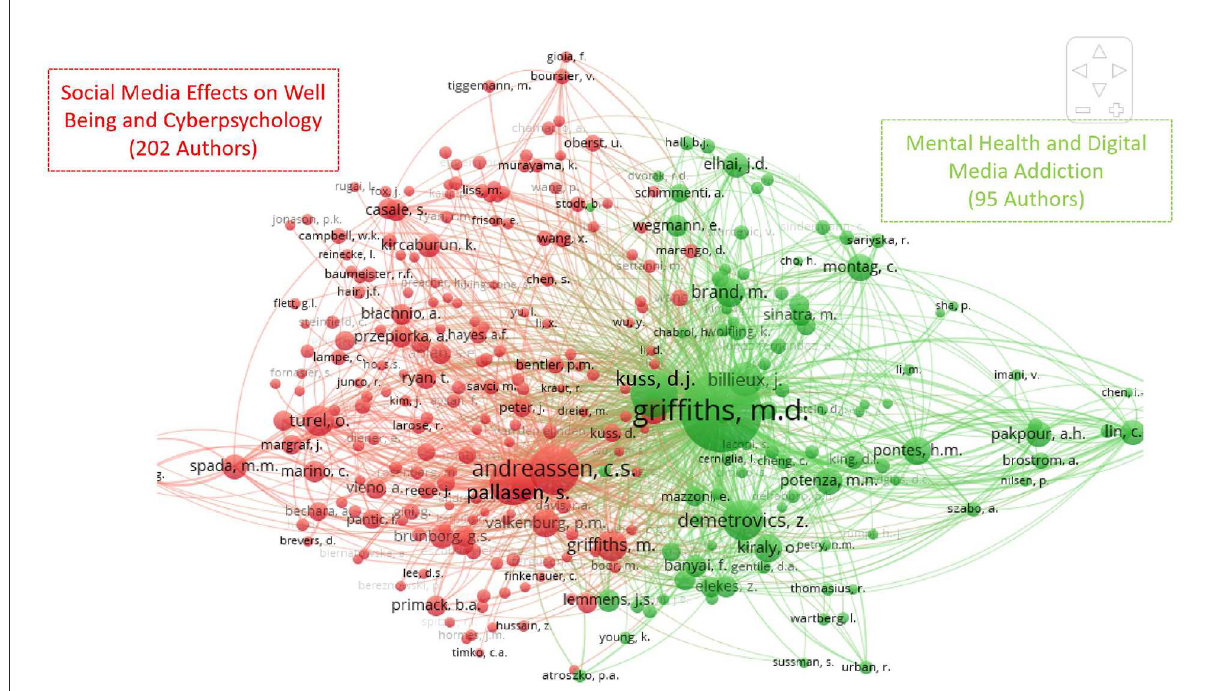
FIGURE4 Two clusters, representing the intellectual structure of the social media and its problematic use